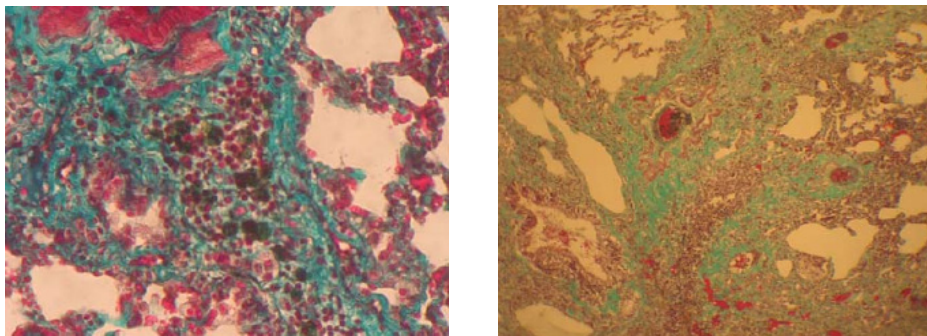
Figure 3. Slice observation of typical lung cases (Masson × 400, left : coal spot and large fibrosis; right : pulmonary interstitial fibrosis and local emphysema) [10].